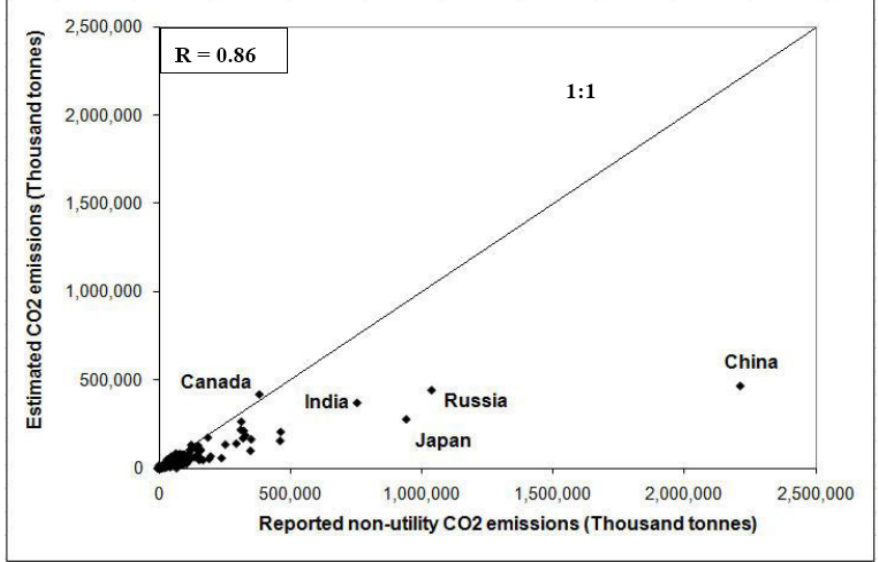
Figure 7. Reported non-utility CO emission values for the countries of the world and the states of the